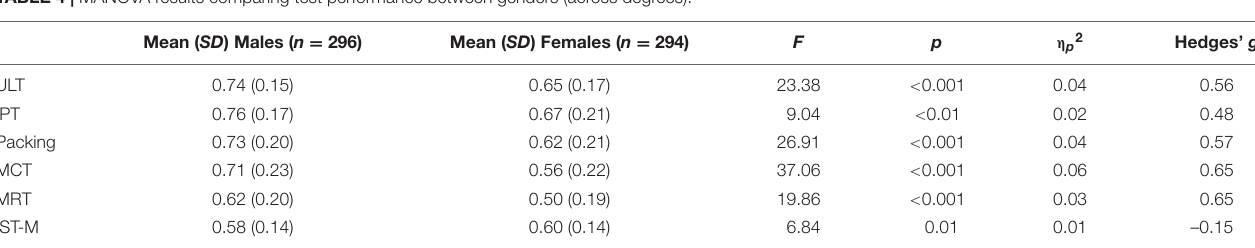
TABLE 4 | MANOVA results comparing test performance between genders (across degrees). Mean ( SD ) Males ( n =